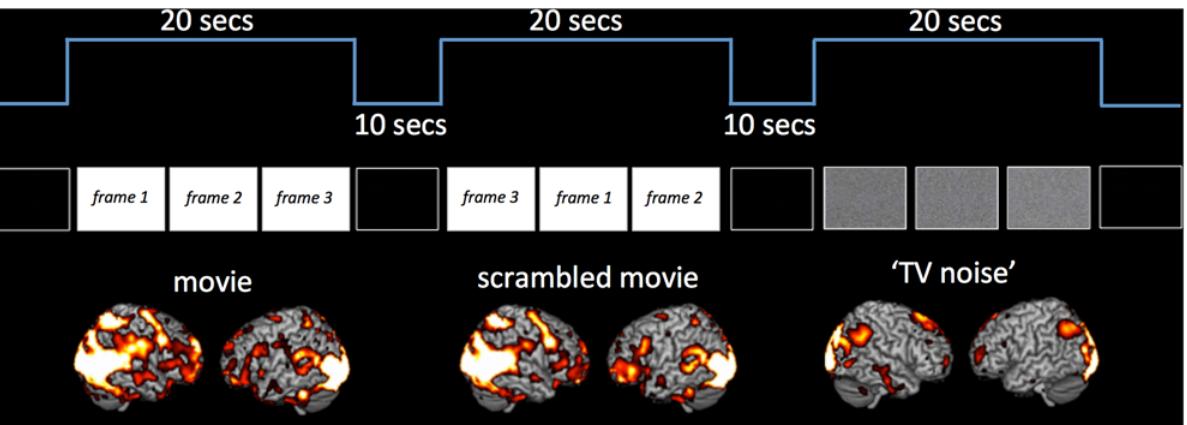
Fig 2. Block design results for movie, scrambled movie and ‘ TV noise ’ sequences. Figure displays overall brain activation for movie, scrambled movie and ‘ TV noise ’ sequences as measured in the block design paradigm. Results shown in a representative subject for T contrasts comparing movie, scrambled movie and ‘ TV noise ’ to a black screen baseline, thresholded at whole brain FWE corrected p <